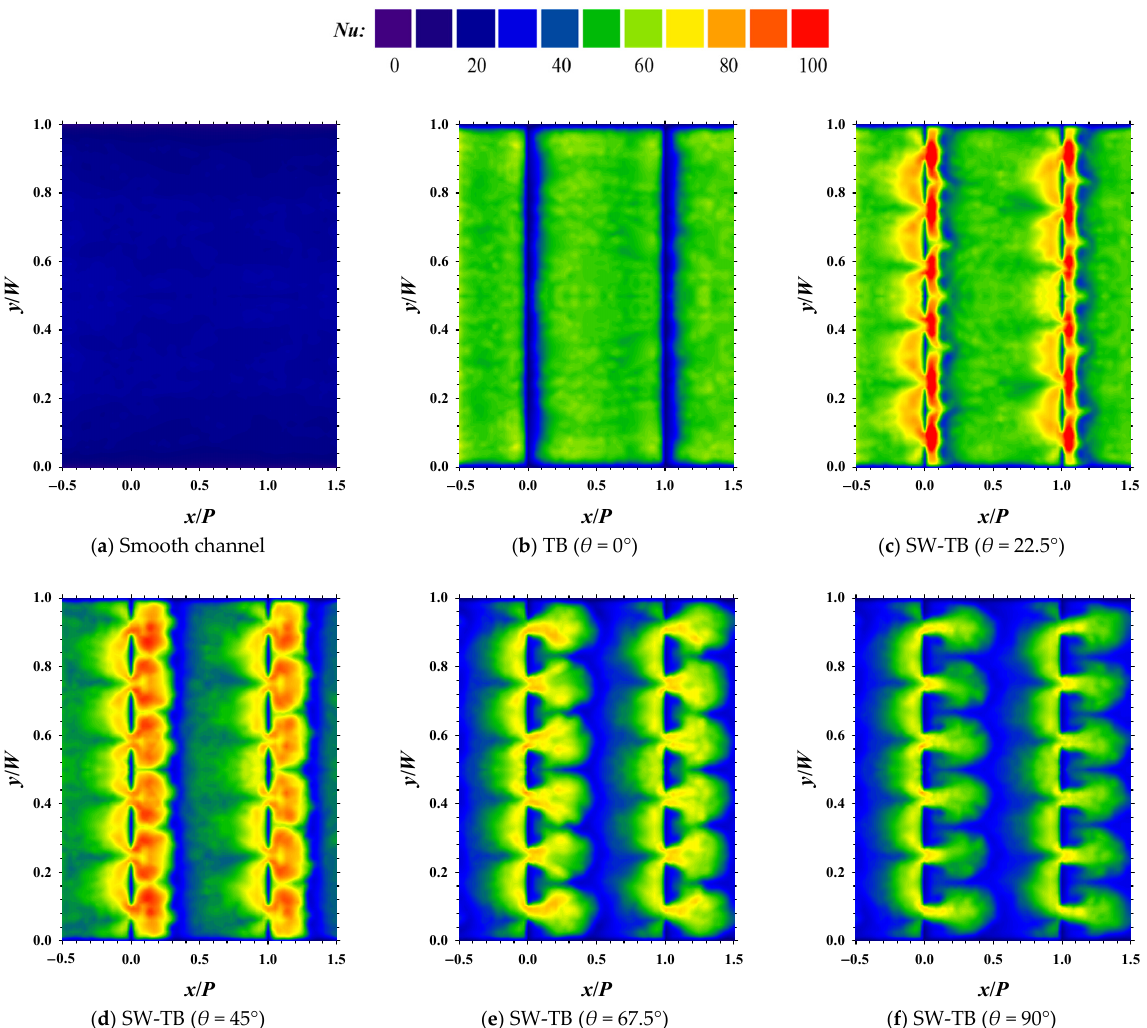
Figure 4. Nusselt number distribution in a channel installed with square-winged transverse baffles (SW-TBs) at Re = 6000.